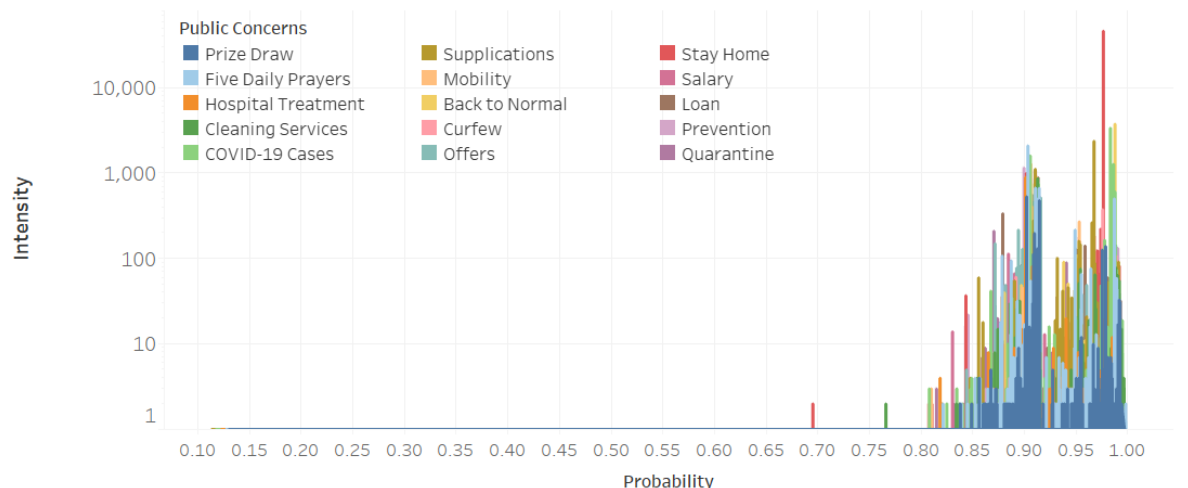
Figure 4. Tweet intensity versus probability of